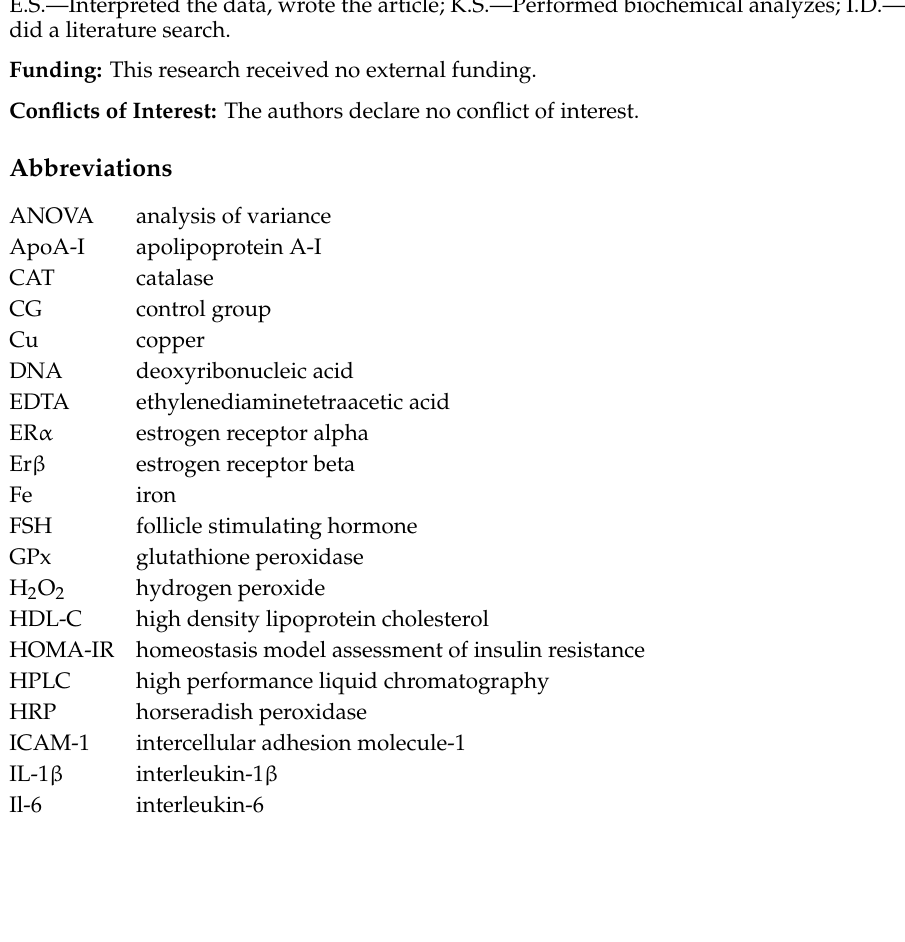
Table S1. Component composition of diets. Table S2. Chemical composition of diets. Table S3. Manufacturers and catalog numbers of reagents used in biochemical